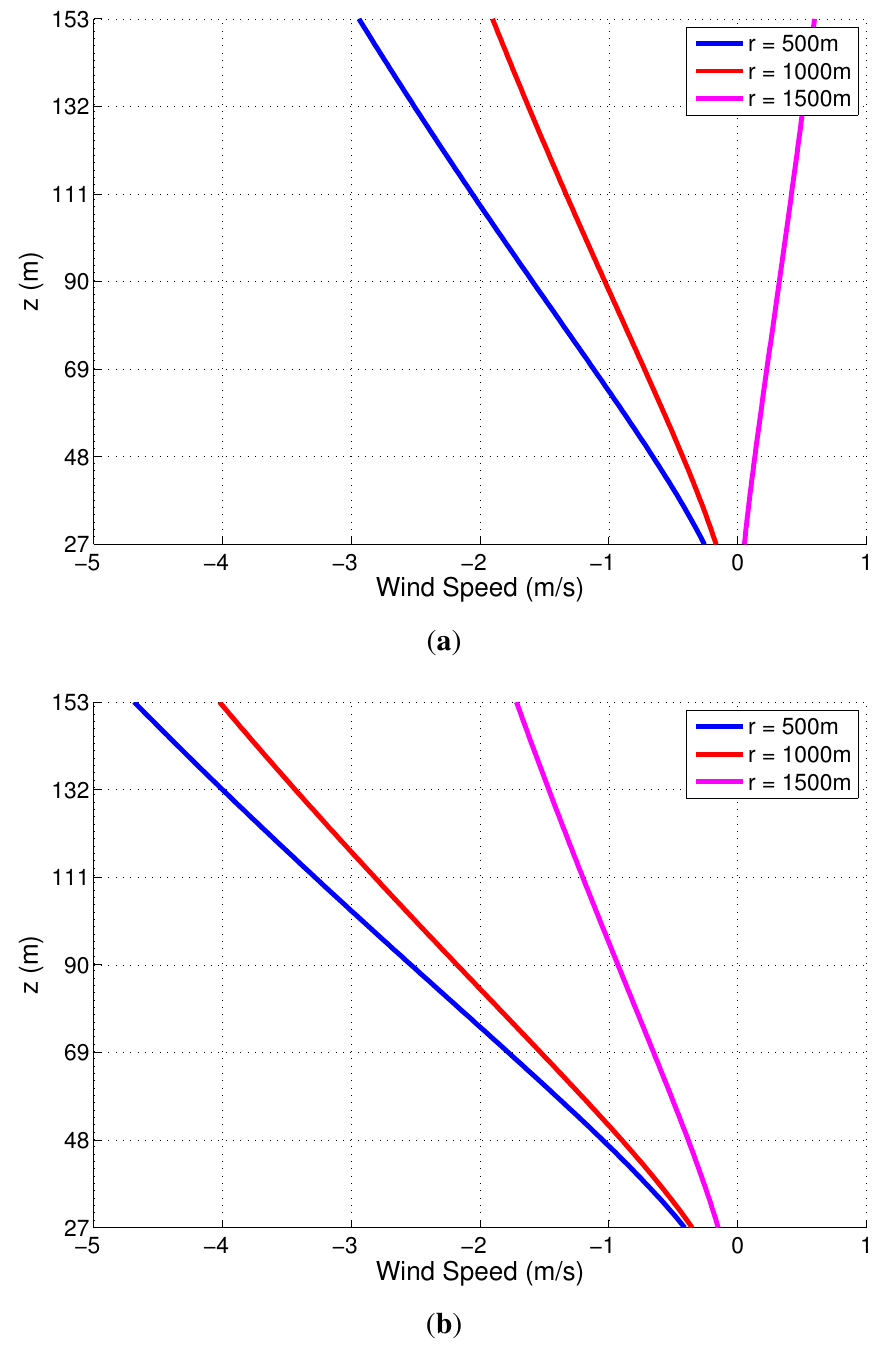
Figure 6. JAWS “Average” non-turbulent vertical wind velocity profiles during the downburst. ( a ) Non-turbulent vertical wind velocity profiles at t = t intensity, Π( t ) = 0 . 5 ; ( b ) Non-turbulent vertical wind velocity profiles at t = t storm intensity, Π( t ) = 1 . 0